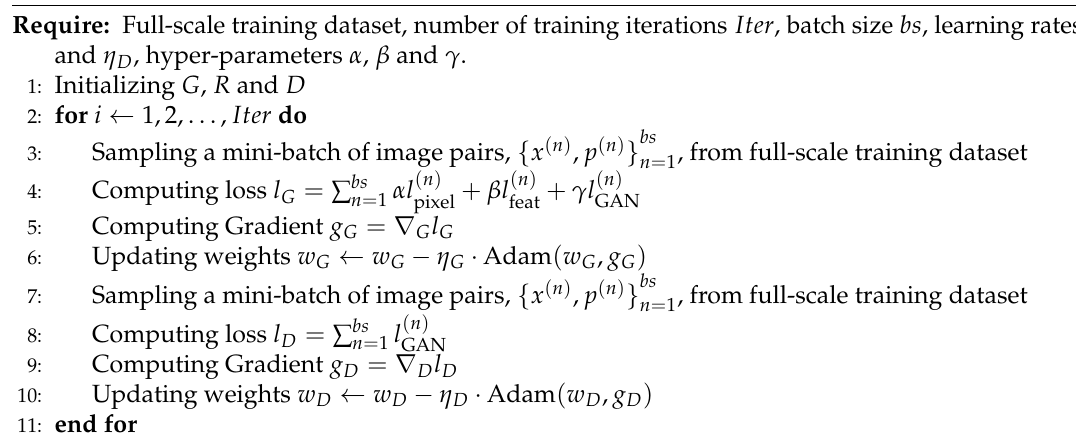
Algorithm 1 Full-scale SPUF training algorithm.